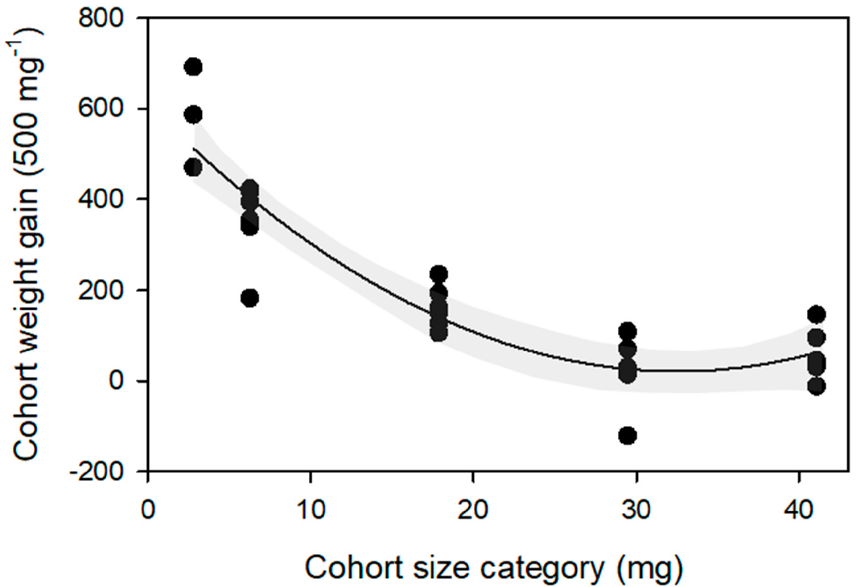
Figure 1. Relationship between average BSF larval size per cohort and absolute weight gain on SCG during 12 days. The curve equation is y = 609.79 − 36.26x + 0.56x 2 (F 2,24 = 57.375, p < 0.001; R 2 = 0.84); 95% confidence intervals are indicated. For further details see Table S1.